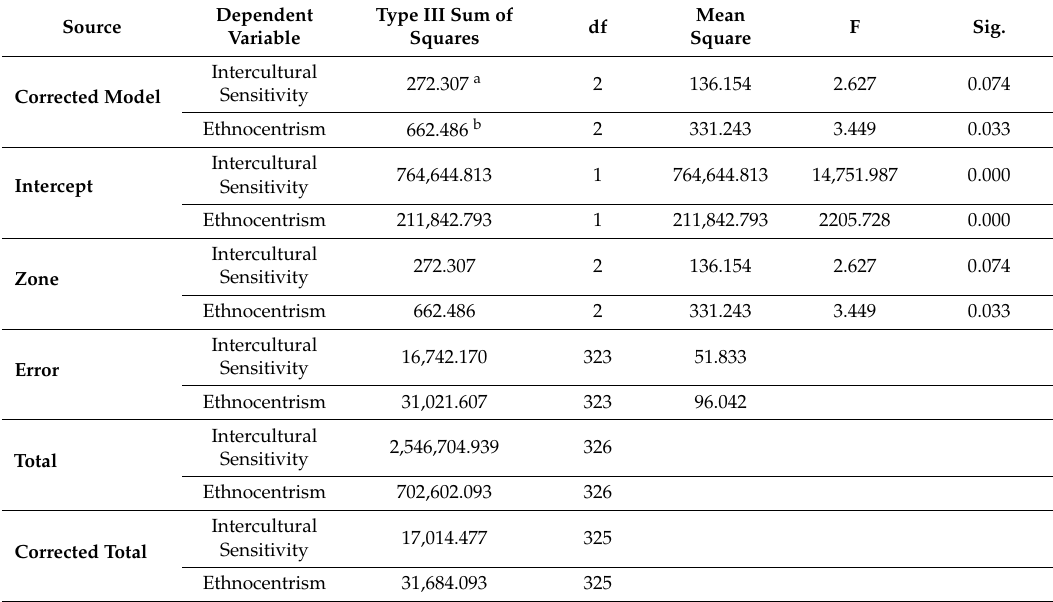
Table 11. The interaction between Intercultural Sensitivity and Ethnocentrism and the zone where the theology students live.